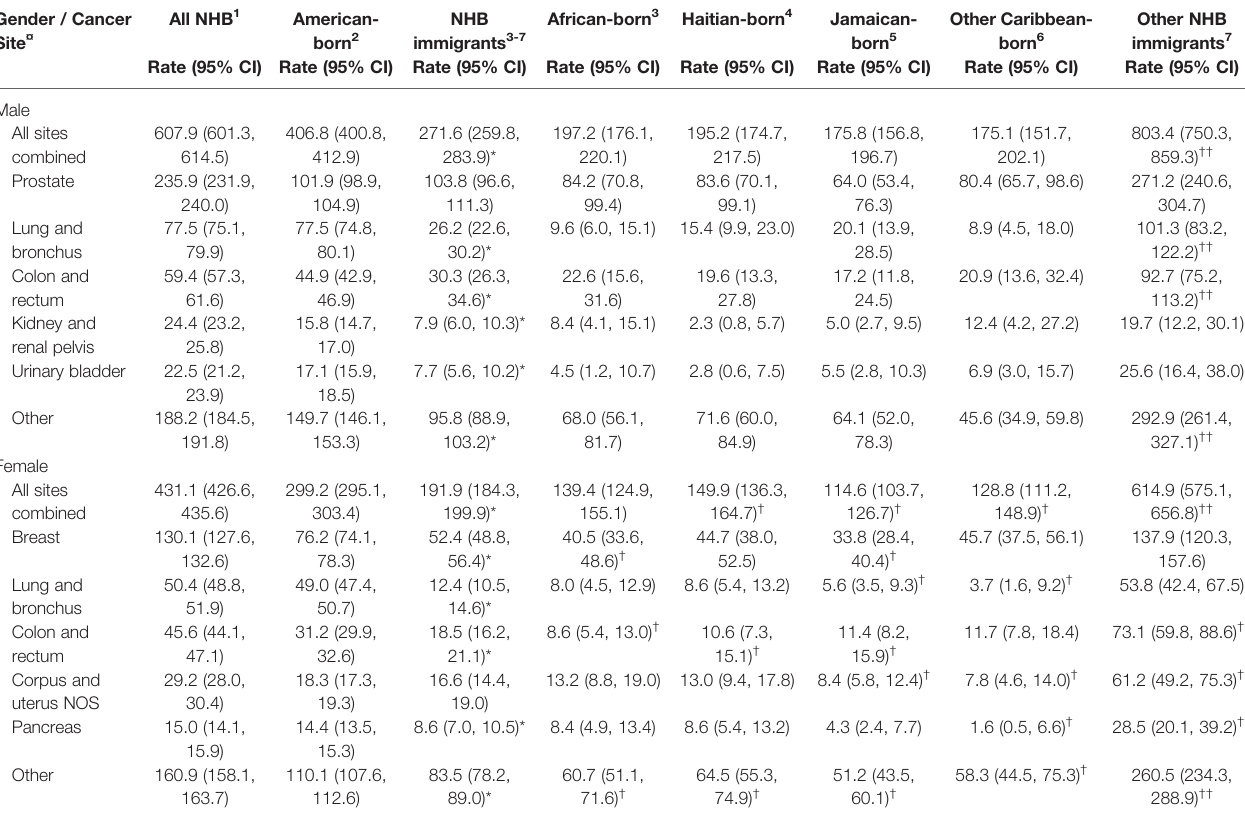
TABLE 2 | Age-adjusted cancer incidence (per 100,000) among non-Hispanic Black (NHB) 1 individuals in New Jersey by nativity and birthplace, and by gender, 2005-2017. Gender / Cancer Site